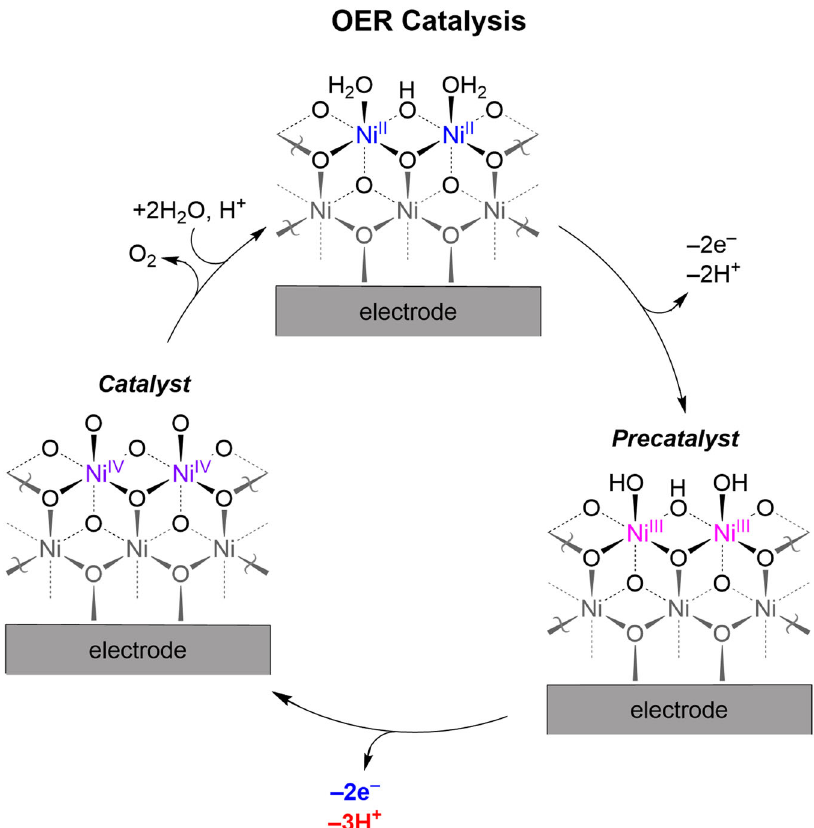
Fig. 5 Ni-OEC catalytic cycle. Proposed OER catalytic cycle for Ni-OEC with B i as an electrolyte, as determined from spectroscopic analysis and electrochemical kinetics studies for NiB i .